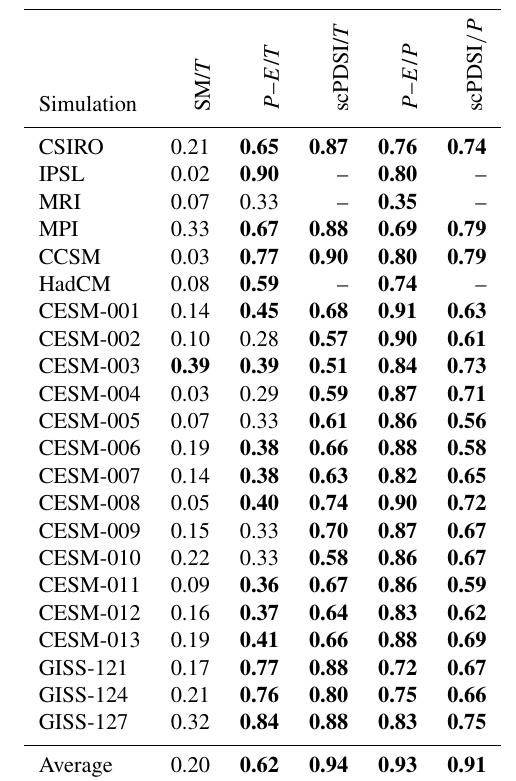
Table 3. Correlations for different simulations of the PC linked to the forcing for soil moisture, P – E , and scPDSI (first PC of scPDSI and second PC of P – E and soil moisture) with the first PC of sur- face temperature and the second PC of precipitation. Correlations of the average PC time series are also included. Significant correla- tions ( p < 0 . 05) accounting for autocorrelations are shown in